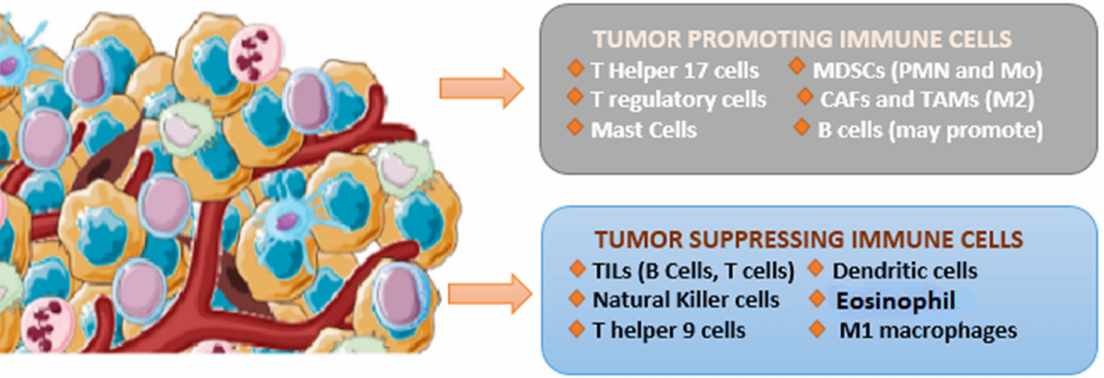
Figure 1. Tumor-suppressing and tumor-promoting cells in the tumor microenvironment of cervi- cal